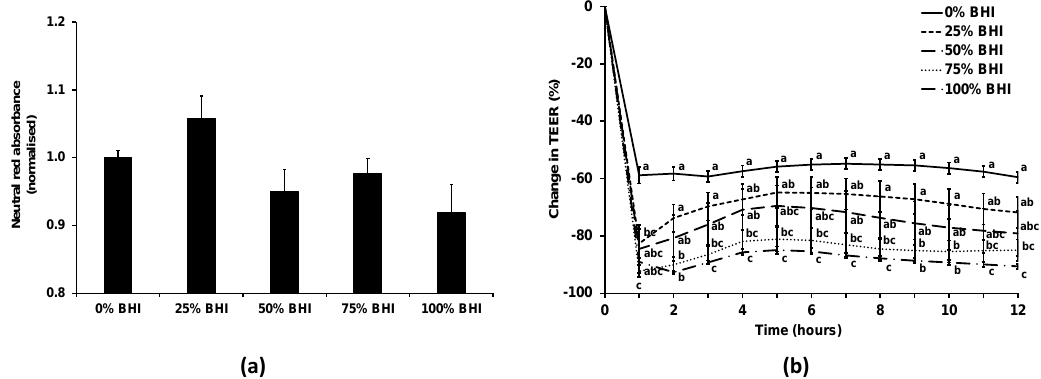
Figure 3. Effect of combining cell and bacterial culture medium on the viability and TEER of Caco-2 cells in the apical anaerobic co-culture model. The apical compartment of Caco-2 cell monolayers were exposed to non-supplemented anaerobic M199 TEER medium (0% BHI), or M199 TEER medium supplemented with increasing concentrations of anaerobic BHI medium (25%, 50%, 75%, or 100% BHI). ( a ) Viability (mean ± SEM; n = 20) of Caco-2 cells after 12 h incubation. Neutral red absorbance was normalized by adjusting the 0% BHI exposed cells to 1. Viability of the Caco-2 cells was unchanged as a consequence of differing culture medium composition ( p = 0.07). ( b ) Mean ( ± SEM; n = 20) change in TEER as a percentage of initial TEER across Caco-2 cell monolayers over 12 h for each medium. There was a significant interaction between the time and the BHI concentration on the change in TEER ( p < 0.01). Treatments that do not share the same letters are significantly different ( p < 0.05).